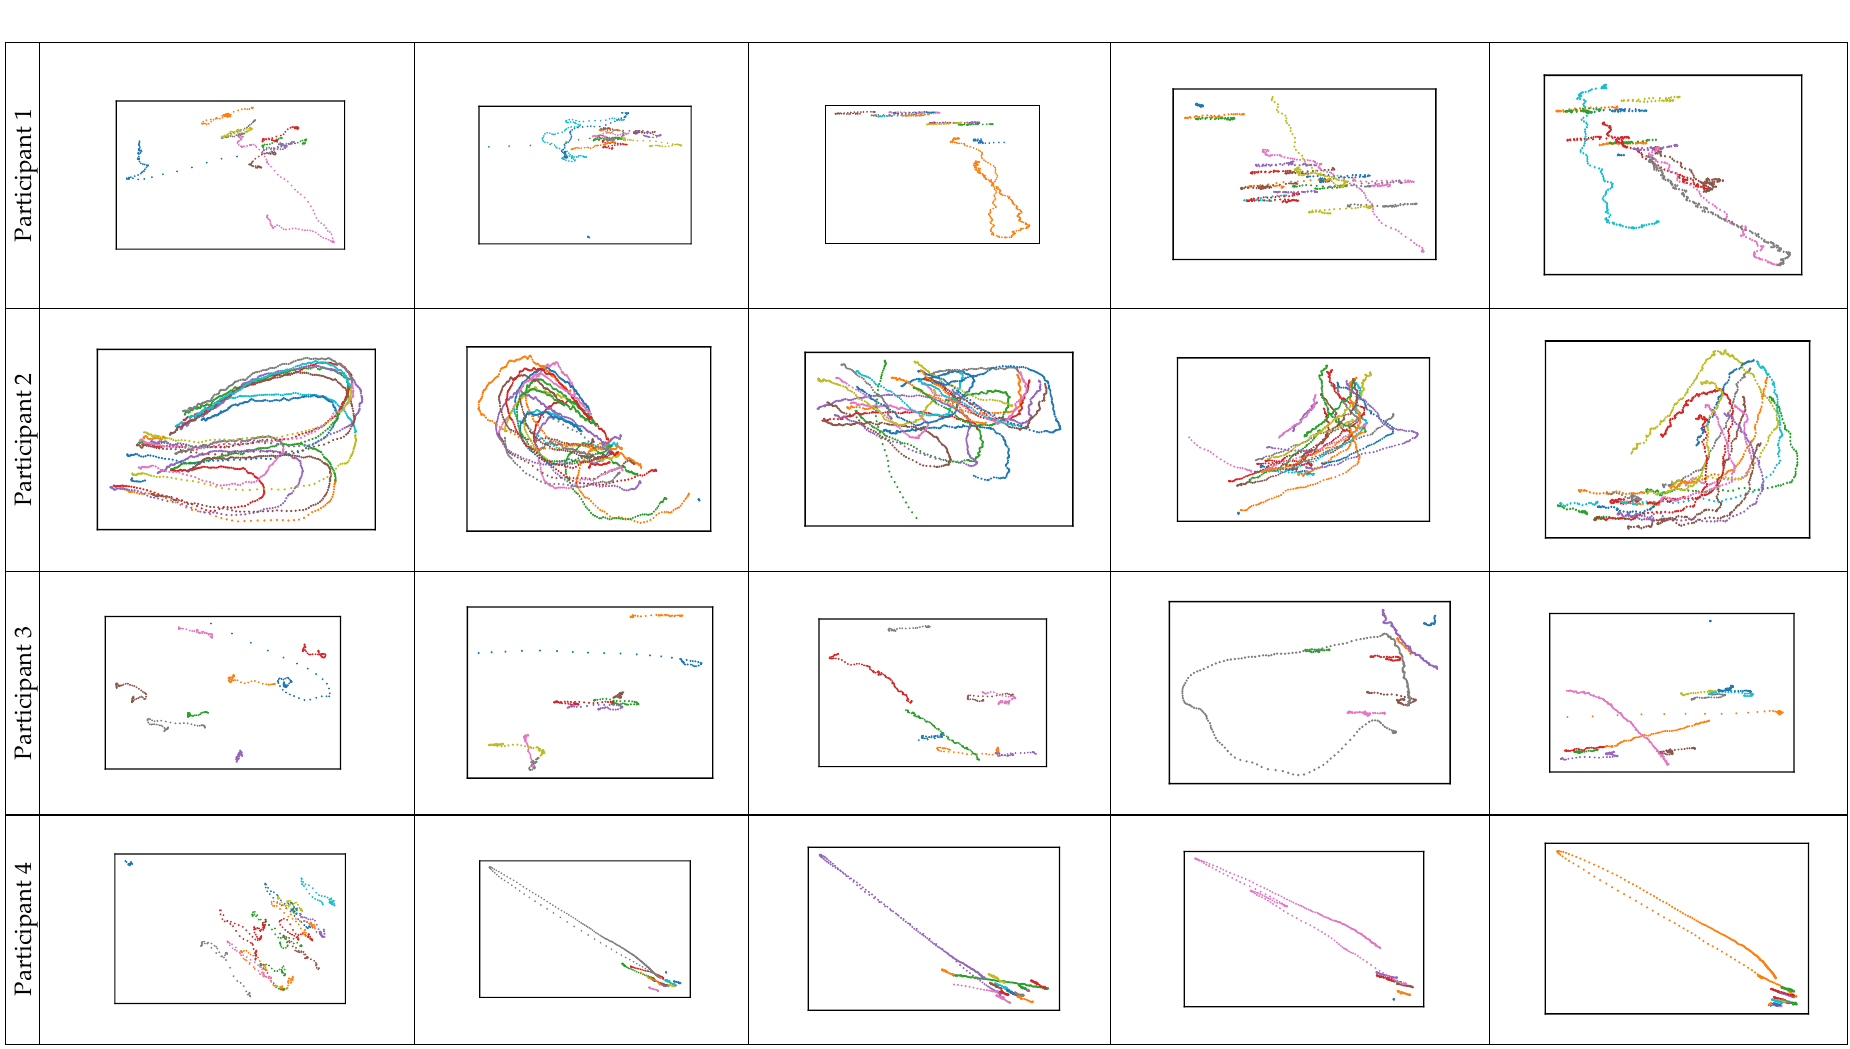
Figure 3. The microsaccades only for left, right, top, bottom and center points, respectively, for the first four of the participants.